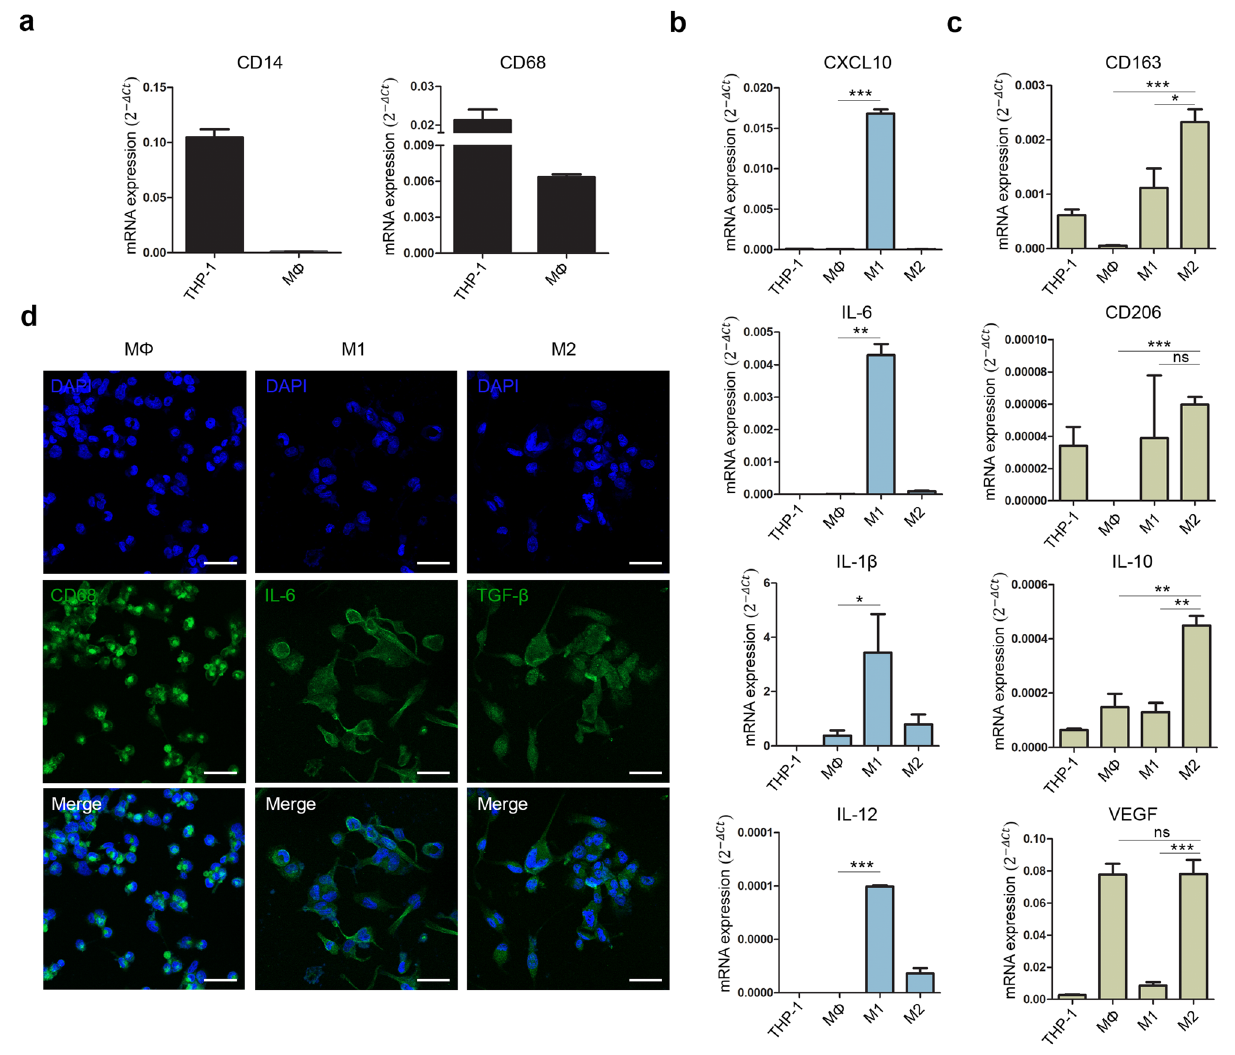
Figure 2. Polarization of M1 and M2 macrophages from THP-1. ( a ) Gene expression of the monocyte marker CD14 and monocyte/macrophage marker CD68 in macrophages differentiated from THP-1 monocytes. ( b ) Expression of the proinflammatory markers CXCL10 , IL-6 , IL-1β , and IL-12 . ( c ) Expression of the anti- inflammatory markers CD163 , CD2206 , and IL-10 and angiogenesis marker VEGF. The relative gene expression values were calculated using the delta cycle-threshold (ΔCt) method. Data are expressed as the mean ± SEM. * p < 0.05, ** p < 0.01, *** p < 0.001 indicate statistical significance. ( d ) Immunofluorescence staining of CD68 (green), IL-6 (green), and TGF-β (green) and DAPI-stained nucleus (blue). Scale bar indicates 100 µm. ns non- significant, MΦ